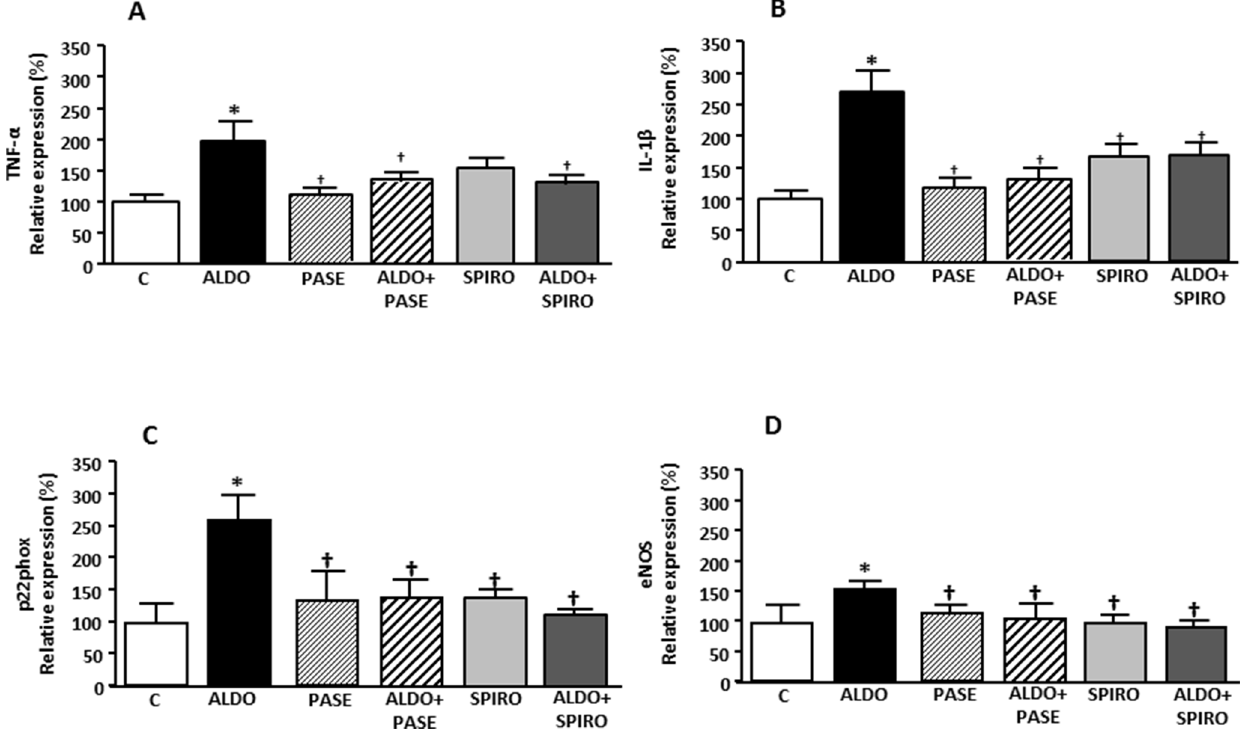
Figure 2. TNF- a (A), IL-1 b (B), p22phox (C) and eNOS (D) mRNA levels in control (C), aldosterone-salt-treated animals (ALDO), PASE (PASE), aldosterone-salt plus PASE treated animals (ALDO + PASE), spironolactone treated animals (SPIRO) and aldosterone-salt plus spironolactone (ALDO + SPIRO). Data are expressed as mean 6 SEM derived from 8 animals per group. *p , 0.05 vs . C; { p , 0.05 vs . ALDO.